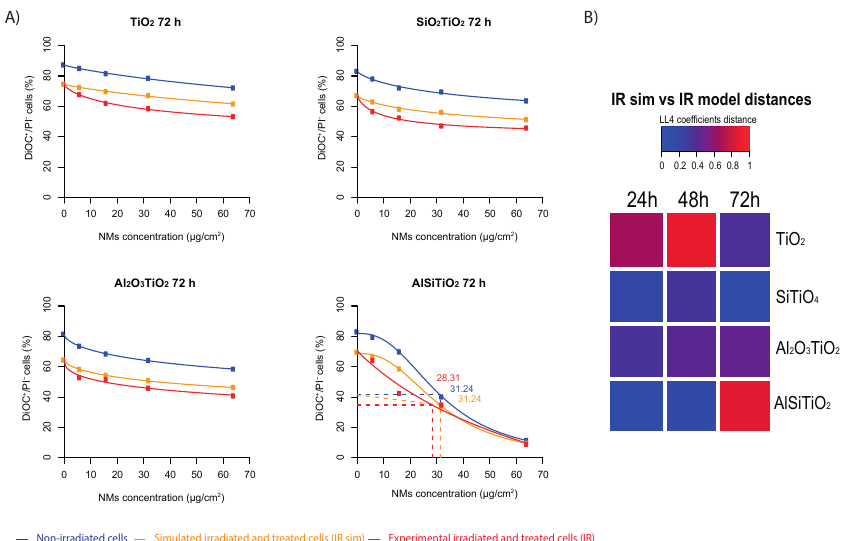
Figure 4. Synergy study between each type of TiO 2 and 4 Gy irradiation. ( A ) Log-logistic model were Fig. 4: Synergy study between each type of TiO2s and a 4Gy irradiation. built (i) to simulate the theoretical effect between each type of NMs and 4 Gy irradiation, and (ii) to A) Log-logistic model were built (i) to simulate the theoretical effect between each type of NMs and a 4Gy irradiation, and (ii) to fit the real effect fit the real effect obtained experimentally. The dotted lines: in the case of AlSiTiO2, the synergistic obtained experimentally. B) Heat map representing a higher or lower effect of experimental toxicity of NMs combined with a 4Gy irradiation versus effect was detectable until around 30 µ g / cm2. ( B ) Heat map representing a higher or lower effect of the theoretical toxicity for 24h, 48h and 72h after treatment. experimental toxicity of NMs combined with 4 Gy irradiation versus the theoretical toxicity for 24, 48 and 72 h after